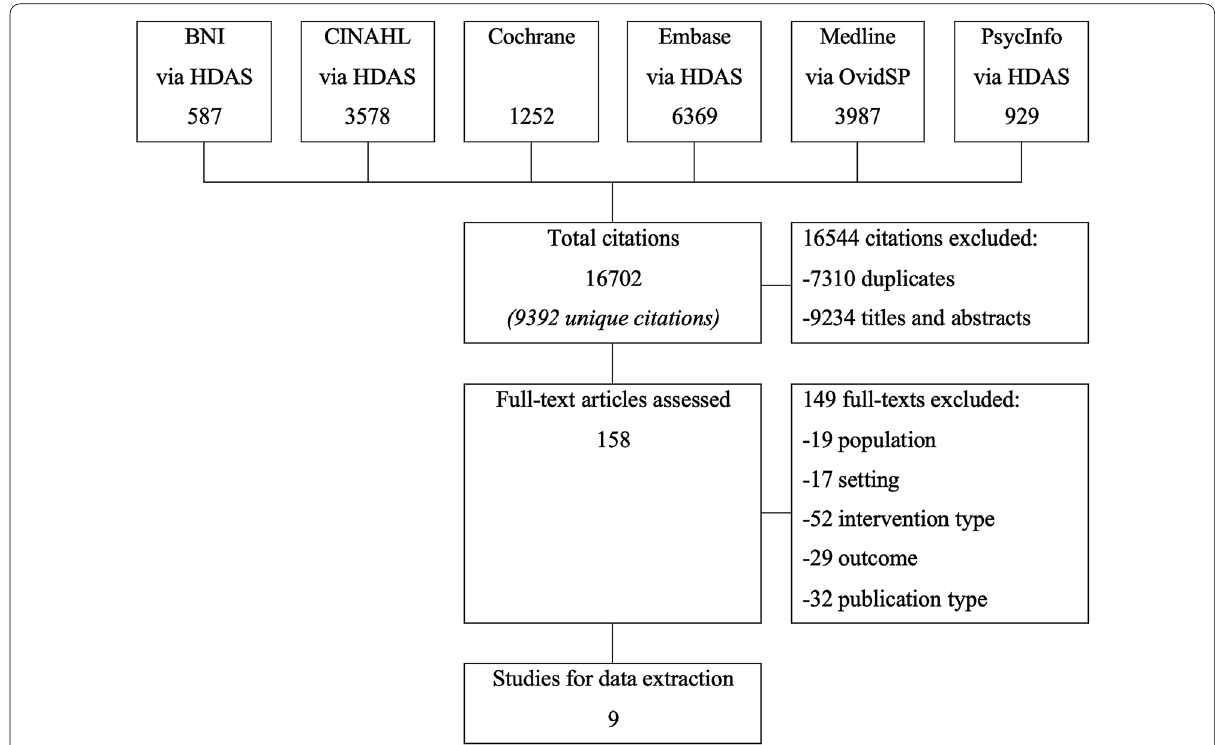
Fig. 2 Citation screening for searches to 24 June